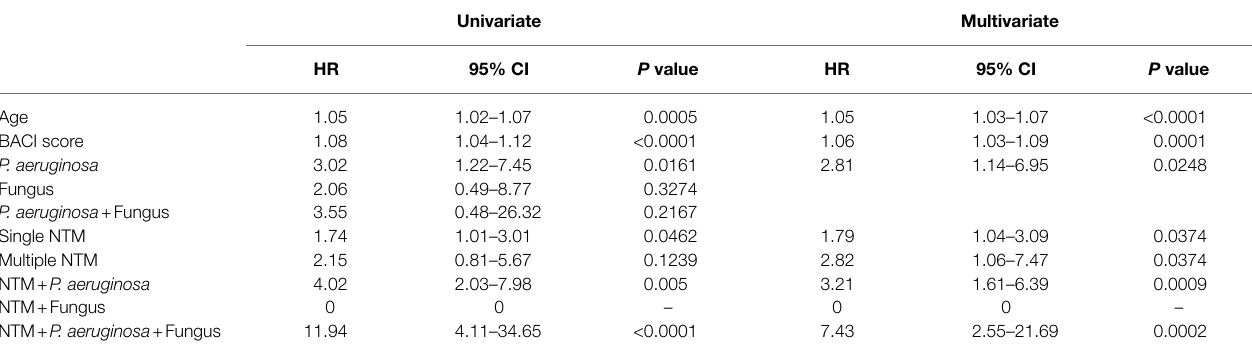
TABLE 3 | Hazzard ratio of mortality according to different pathogen isolates from sputum. Univariate Multivariate